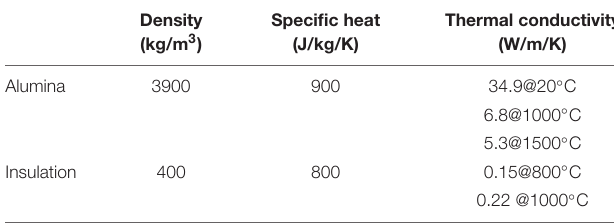
TABLE 1 | Main properties of solids.